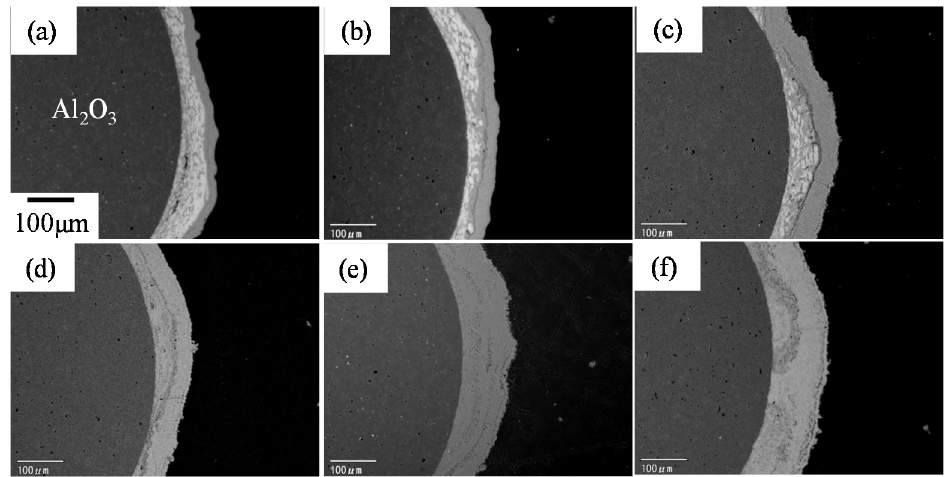
Figure 37. Cross-section SEM images of M10-1173 K- y h samples. ( a ) 0.5 h, ( b ) 1 h, ( c ) 3 h,